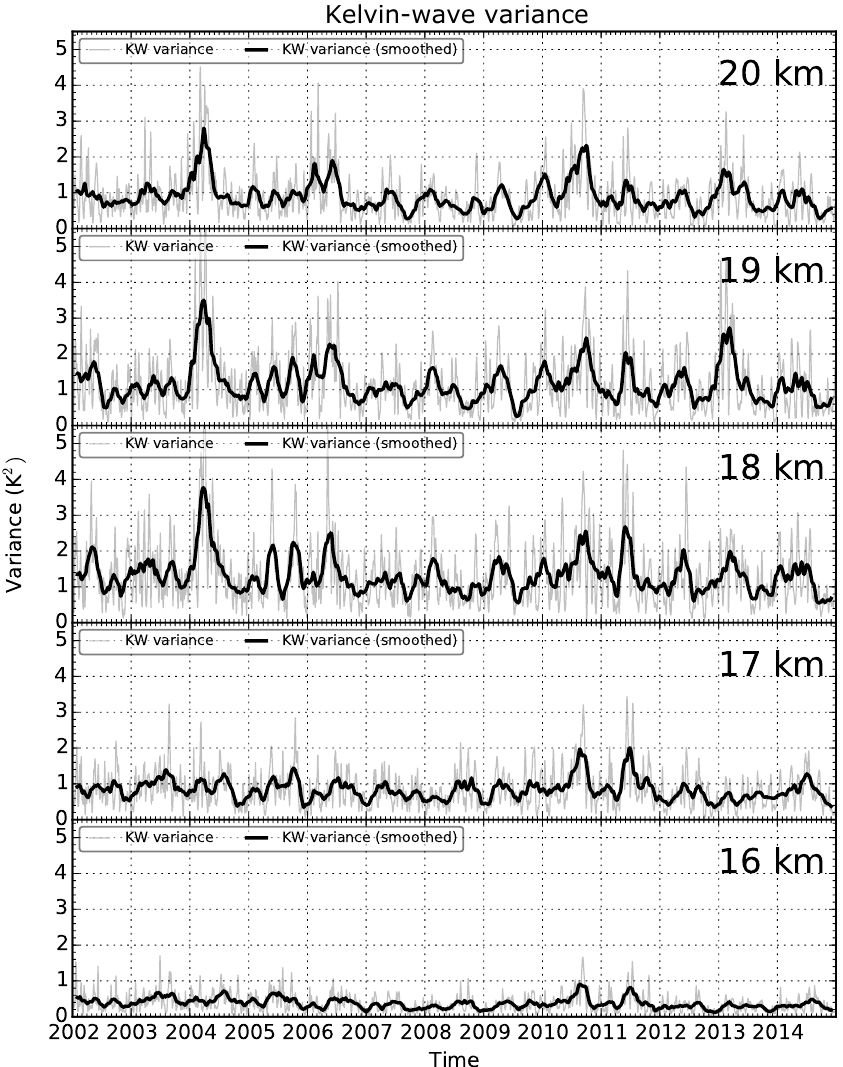
Figure 8. Time series of daily Kelvin-wave variance (thin gray) and smoothed Kelvin-wave variance (thick black) from January 2002 to December 2014 for every kilometer between 20 (top) and 16km